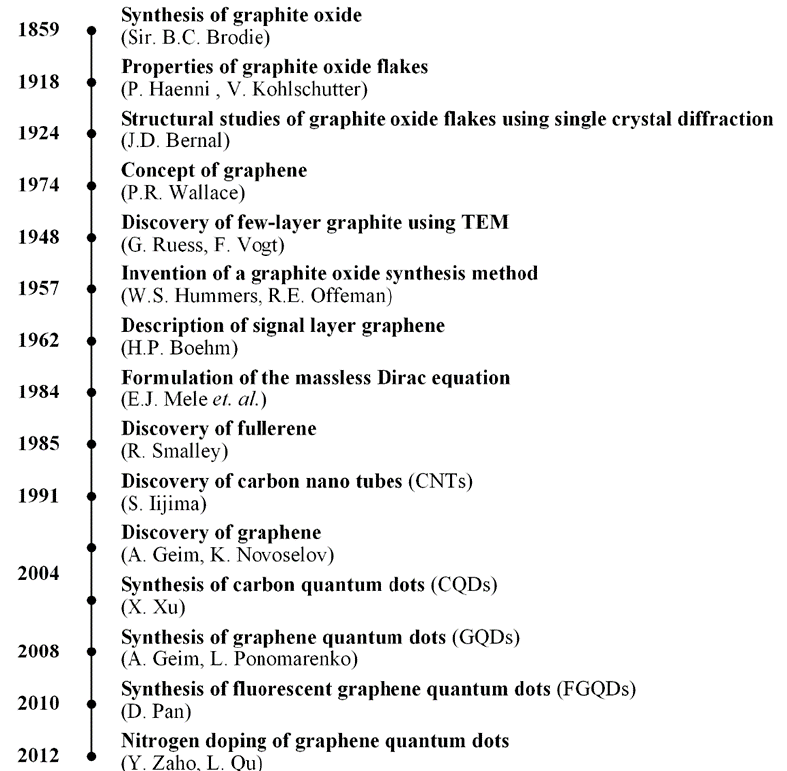
Figure 1: The timeline of the development of functional carbonaceous materials and related theory (Tian et al., 2018).